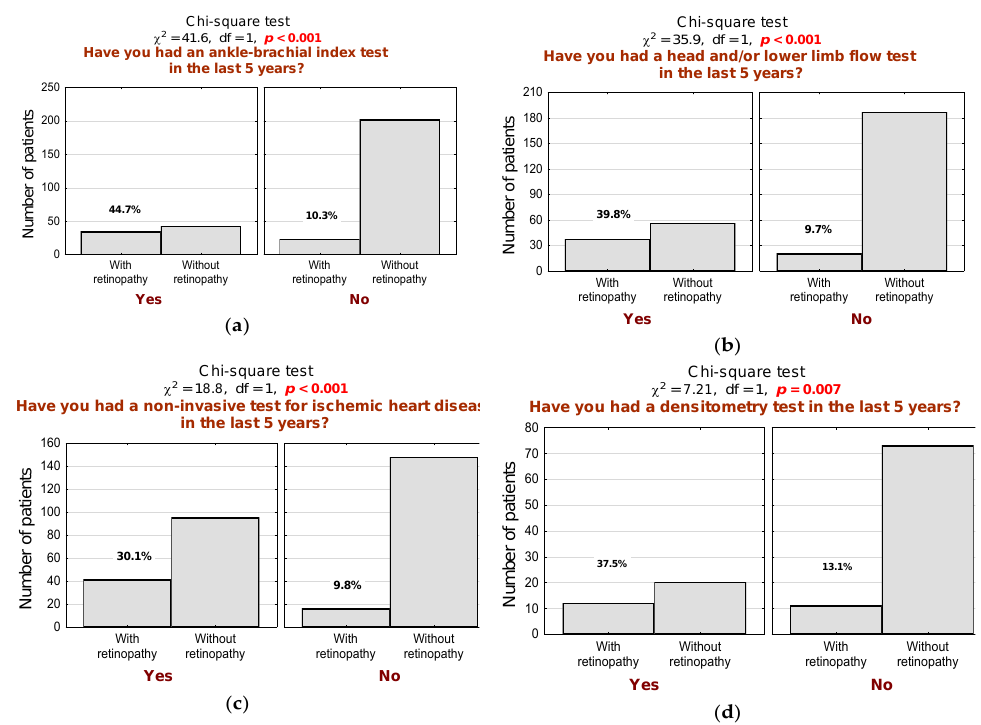
Figure 3. ( a ) Number ( n ) and percentage (%) of patients in groups that differ in the presence of diabetic retinopathy and ankle-brachial index measurement and the test of independence; ( b ) number ( n ) and percentage (%) of patients in groups that differed in the presence of diabetic retinopathy and Doppler ultrasound test of carotid or femoral blood flow measurement and the result of the independence test; ( c ) number ( n ) and percentage (%) of patients in groups differing in the presence of diabetic retinopathy and non-invasive testing for ischemic heart diseases, such as cardiac stress test, stress ECHO test, magnetic resonance imaging of the heart or myocardial perfusion scintigraphy and the test of independence; ( d ) number ( n ) and percentage (%) of patients in groups differing in the presence of diabetic retinopathy and densitometry testing and the result of the independence test .